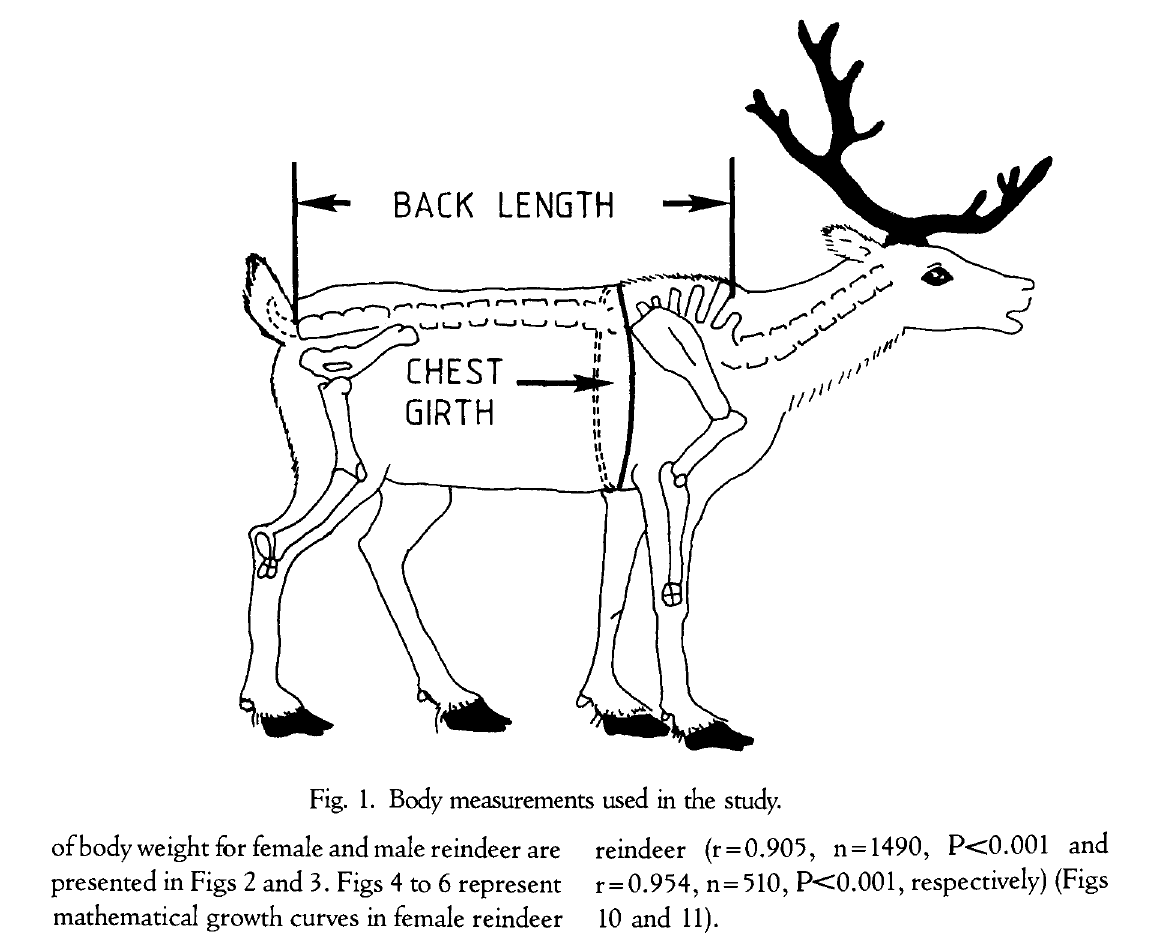
Fig. 1. Body measurements used in the